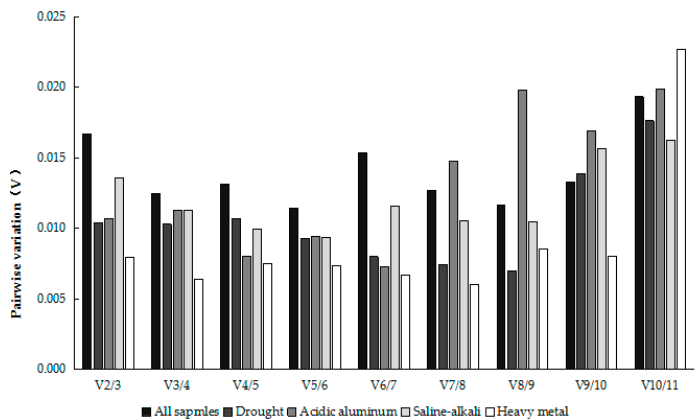
Figure 5. Pairwise variation (V) measure of the candidate reference genes. When V n /V n +1 < 0.15, then the optimal number of reference genes is N.